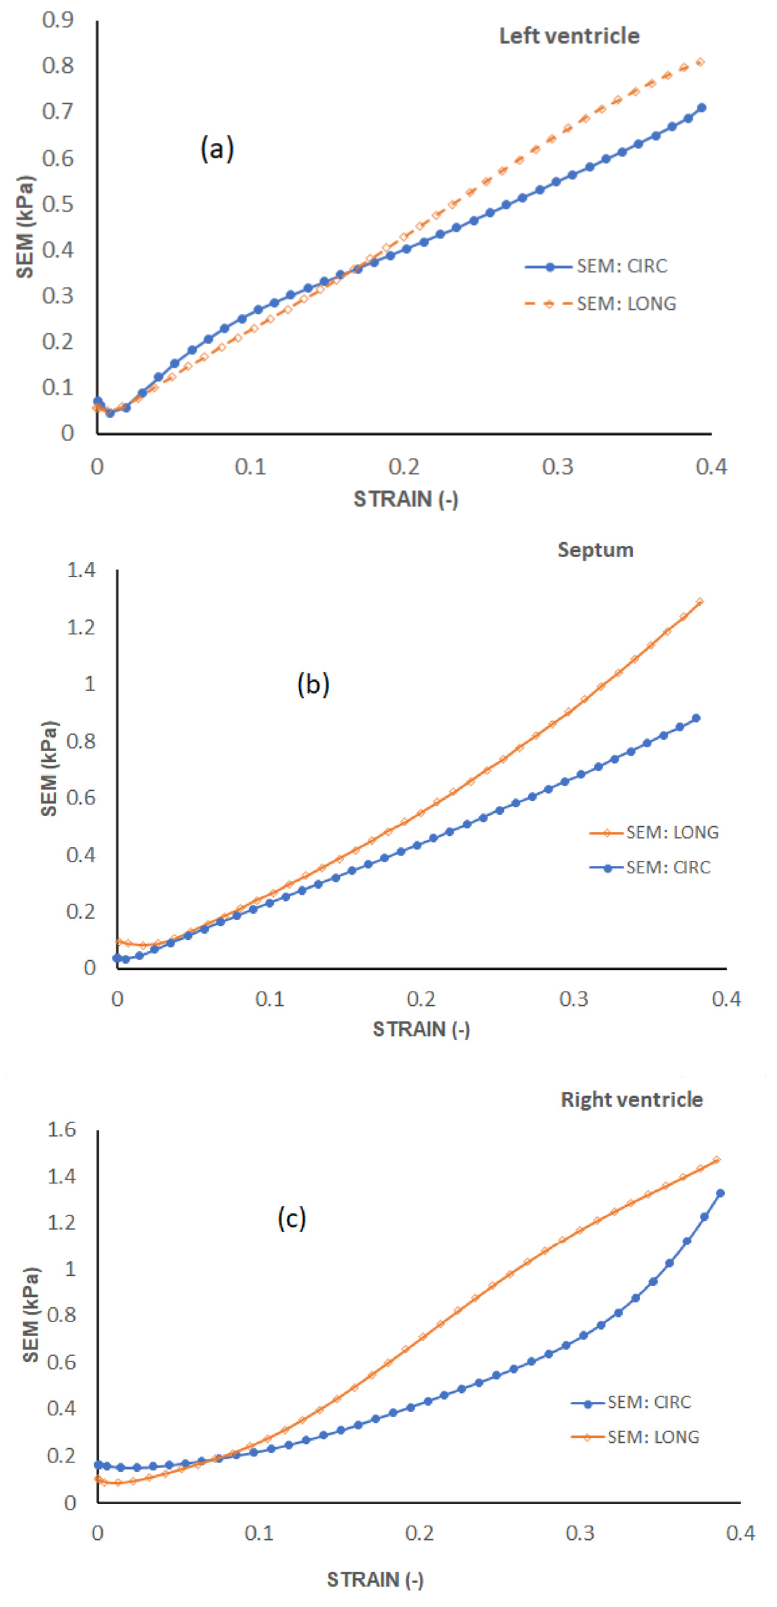
Figure 6. Standard error of the mean (SEM) for the three heart walls along each direction. ( a ) Standard error of the mean (SEM) of the LV, ( b ) Standard error of the mean (SEM) of Septum and ( c ) Standard error of the mean (SEM) of